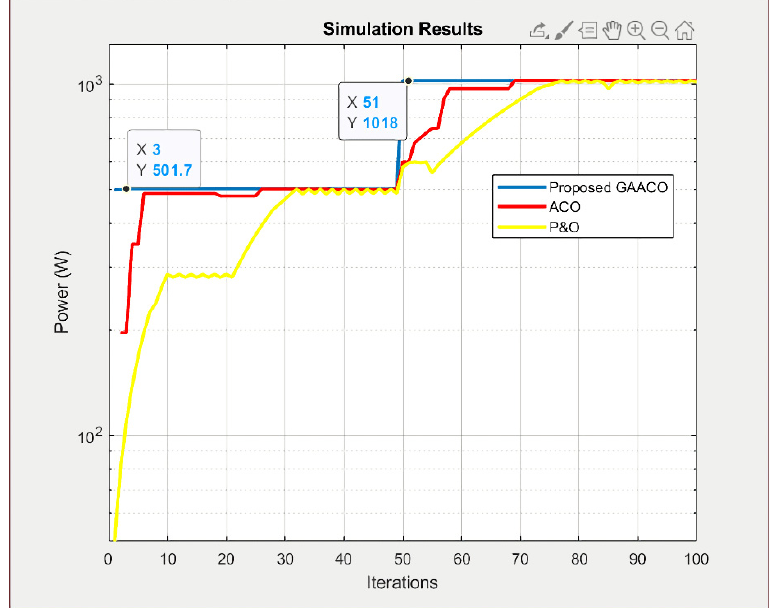
Figure 13. Simulation results of the proposed GA-ACO MPPT compared with P&O and conventional ACO MPPTs in Case 5 (Case 4 changed to Case 2).